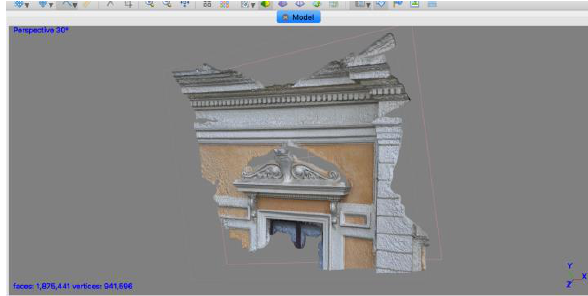
Figure 4 Decorative detail of a large window, by Photoscan photo-modelling. Reference for digital redrawing.